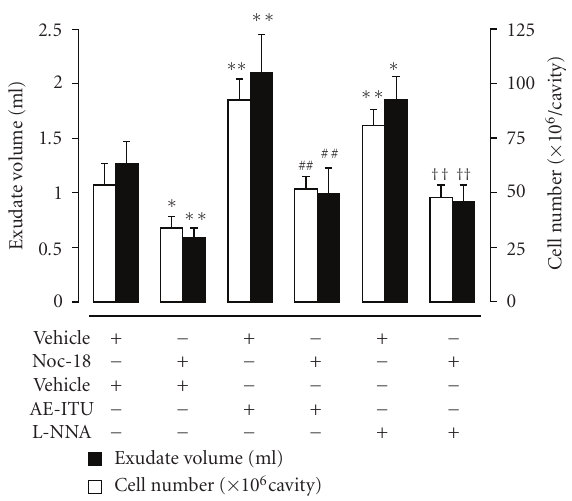
Exudate volume (ml) Cell number ( × 10 6 cavity) Figure 5: E ff ects of NOC-18 on the influence of AE-ITU and L- NNA on exudate volume (empty columns) and cell infiltration (filled columns) 6 hours after Cg challenge. Each column represents the mean ± S.E.M. of 6 rats. ∗ P < . 05, ∗∗ P < . 01 as compared to the vehicle plus vehicle; ## P < . 01 as compared to the vehicle plus AE-ITU; †† P < . 01 as compared to the vehicle plus